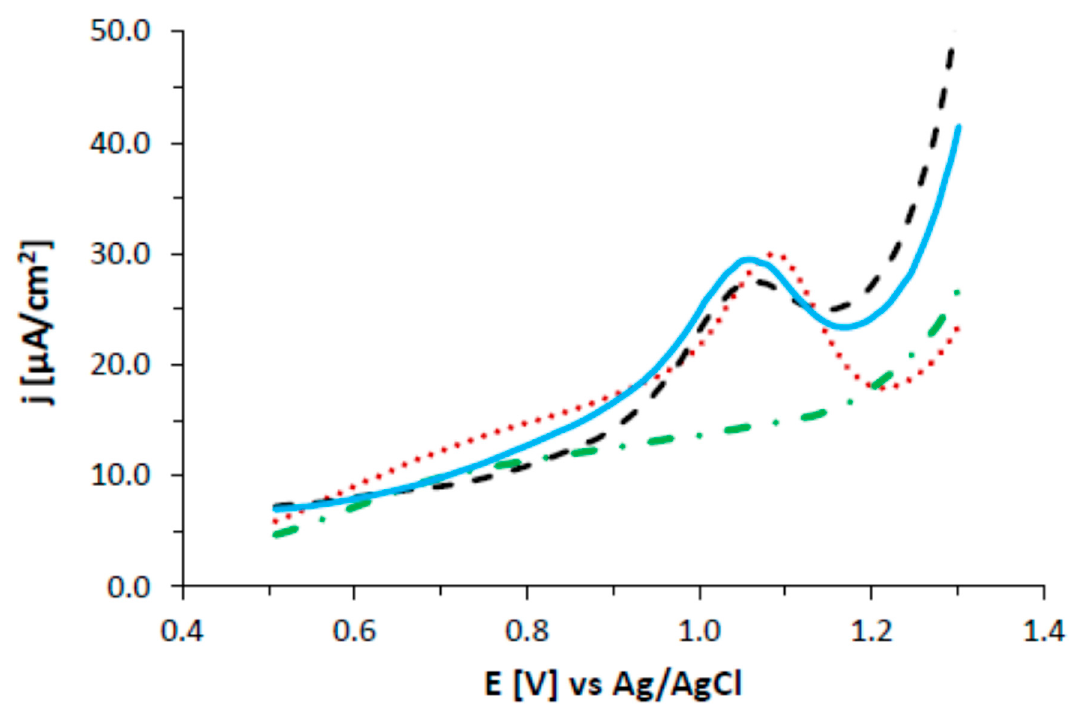
Figure 12. DPV voltammograms (pulse amplitude 50 mV, pulse width 50 ms, potential step 16 mV) recorded using GCE electrodes in deoxygenated DMSO solutions with 0.1 M TBAHFP (green dashed dotted line) background without AB, (red dotted line) with 100 µM AB, and (blue solid line) the AuNPs–AB pH 3.6 conjugate and (dark dashed line) the AuNPs–AB pH 7.4 conjugate transferred to a pure supporting electrolyte.